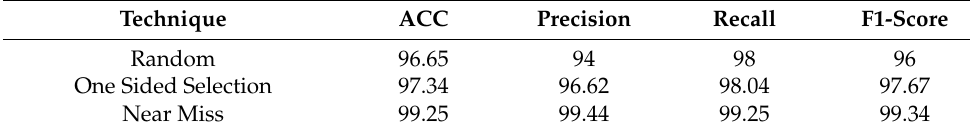
Table 6. Evaluation metrics for the CICIDS2017 dataset with undersampling.